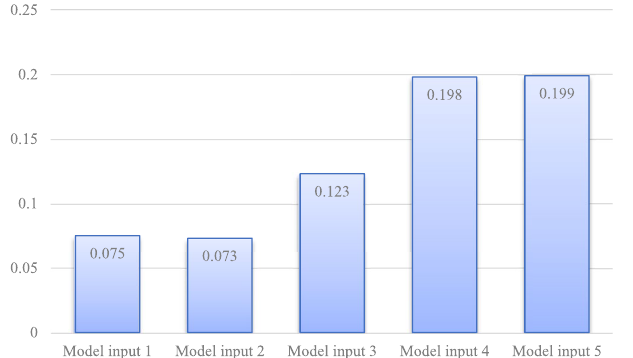
Figure 12. Comparison of R 2 under different model